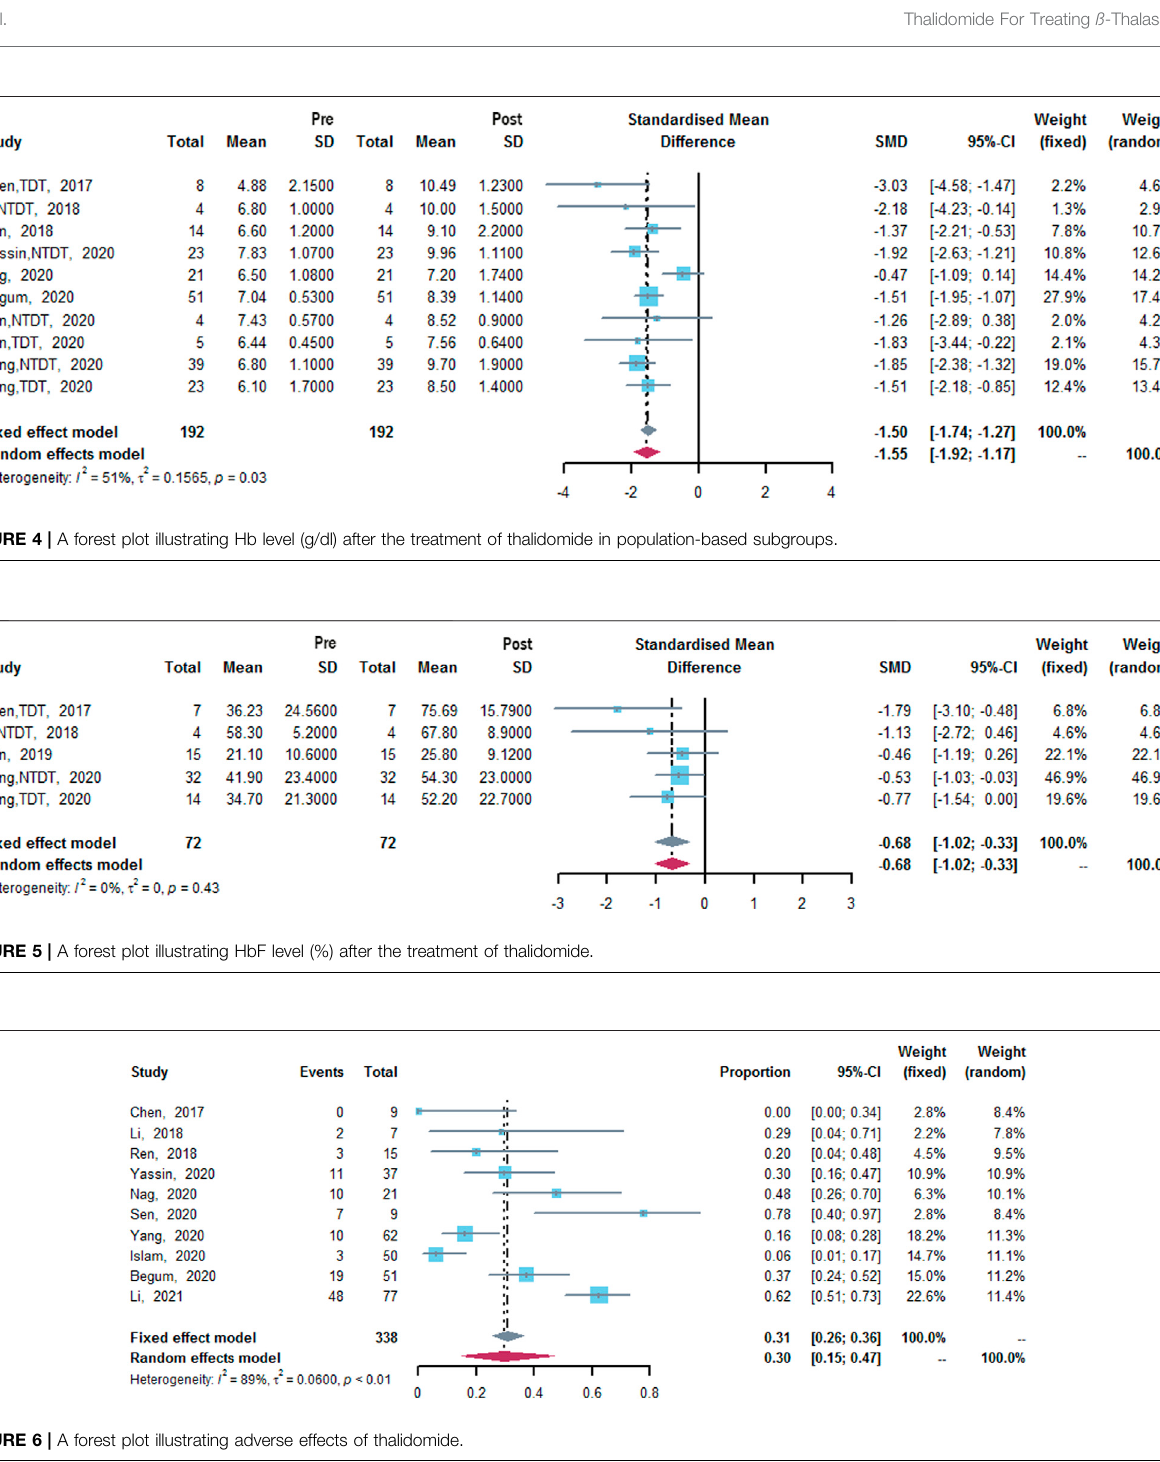
Frontiers in Pharmacology |